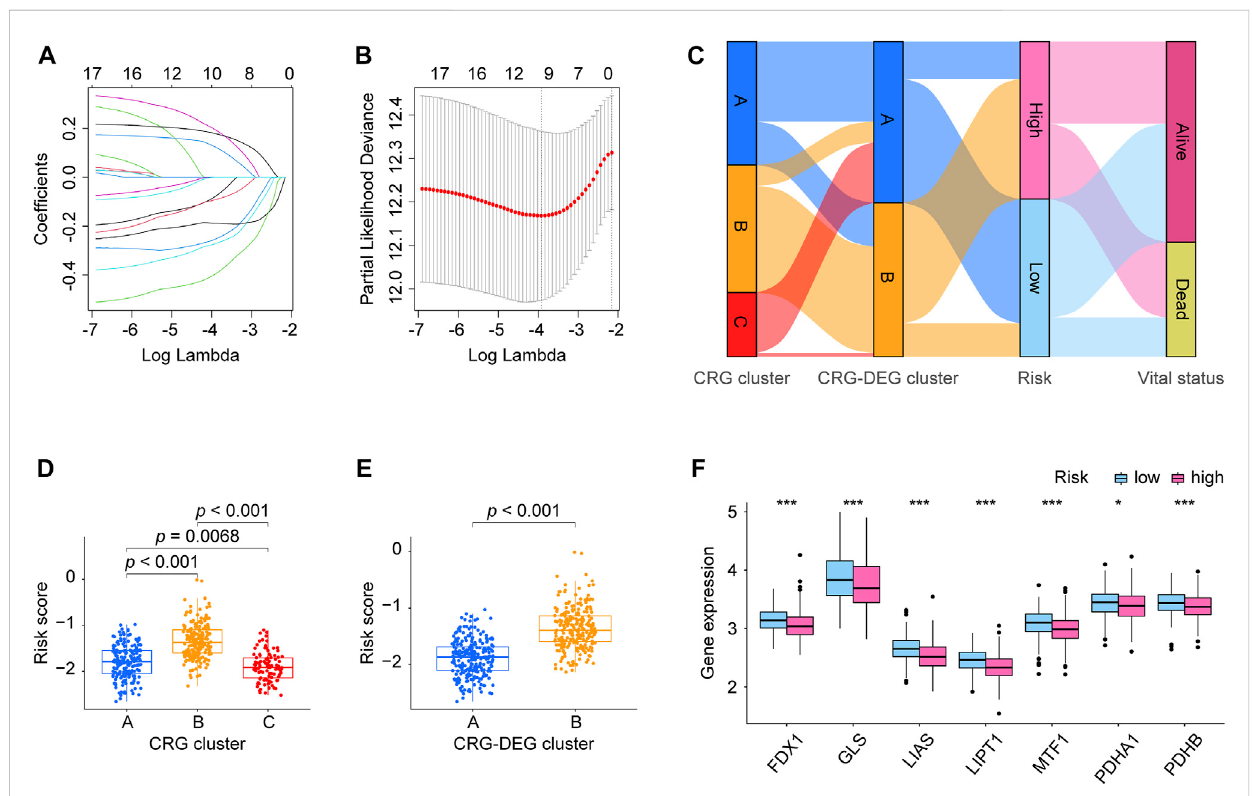
FIGURE 4 Risk model CRLncSig development. (A) LASSO coef fi cient pro fi les of prognostic lncRNAs enrolled. (B) LASSO regression with ten-fold cross- validation obtained nineprognosticgenesusingtheminimumLambda. (C) Sankey diagrams describes therelationshipofCRG cluster,CRG-DEGcluster, risk, and vital status. (D) Boxplots shows the distribution of risk score within the CRG cluster was signi fi cantly different between each two clusters. (E) Boxplots displays the distribution of risk score was signi fi cantly different within the CRG-DEG cluster. (F) Boxplots exhibits expression pattern of the ten CRGs (FDX1, LIAS, LIPT1, DLD, DLAT, PDHA1, PDHB, MTF1, GLS, and CDKN2A) in the high- and low-risk groups. Seven genes (FDX1, LIAS, LIPT1, PDHA1,PDHB,MTF1,andGLS)werefoundhavingdownregulatedexpressionvaluesinthehigh-riskgroupthanthatinthelow-riskgroup,whichstatistics signi fi cantly.CRLncSig:cuproptosis-regulatedlncRNAsignature;LASSO:leastabsoluteshrinkageandselectionoperator;FDR:falsediscoveryrate.CRG: cuproptosis-regulatedgene;DEGs:differentiallyexpressedgenes;KM:Kaplan – Meierestimator; p-value < 0.05wasconsideredstatisticallysigni fi cant;*: p- value < 0.05; ***: p-value < 0.001.